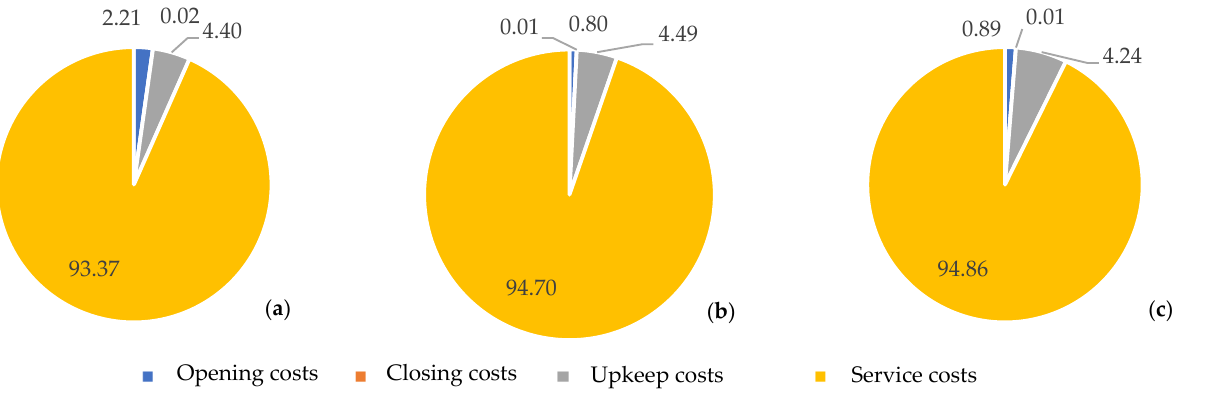
Figure 8. ( a ) Percentage breakdown of the total costs for the first year. ( b ) Percentage breakdown of the total costs for the second year. ( c ) Percentage breakdown of the total costs for the third year.